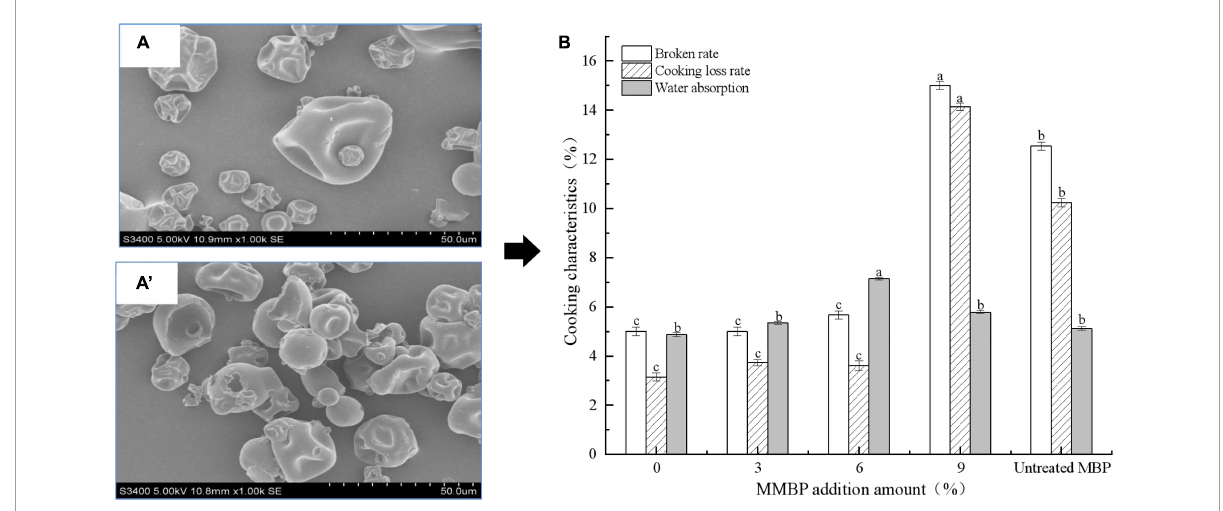
FIGURE3 Cooking properties of noodles treated with different MMBP amounts (0, 3, 6, and 9%). (A) and (A’) Microstructure of the hydrothermally treated and untreated MBPs, respectively. (B) Cooking properties of the noodles. The letters a–c indicate significant differences between the